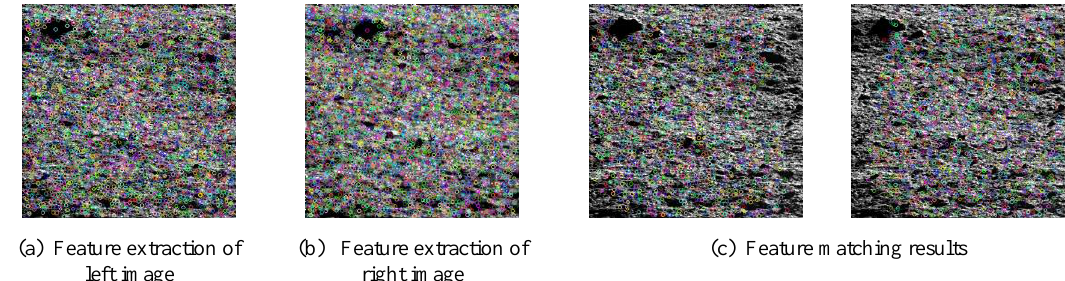
Figure 5. Feature extraction and matching results of ChangE-3 lunar stereo